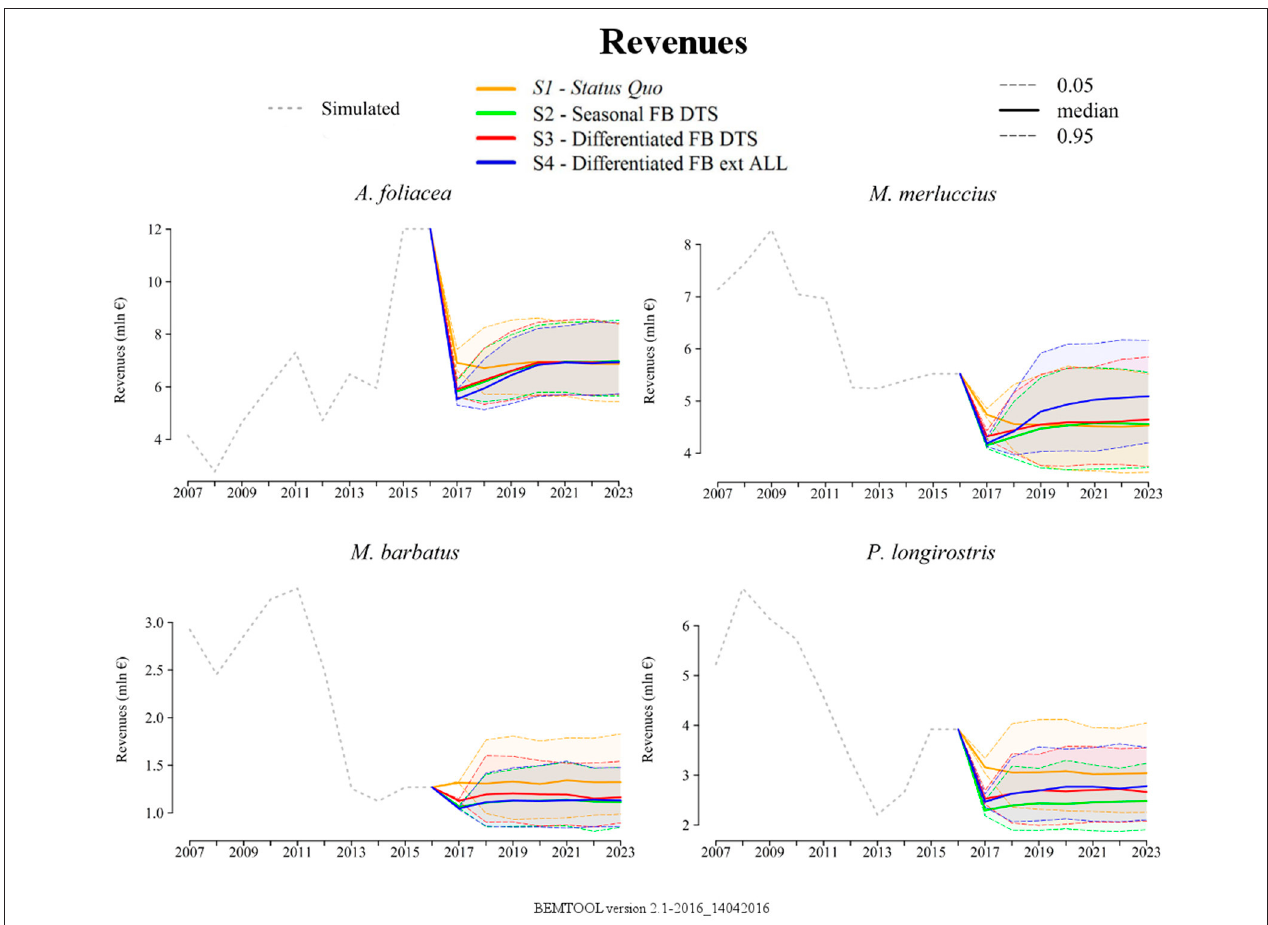
FIGURE 8 | Comparison among the scenarios of revenues (all gear) in the hindcasting (2007–2016) and forecasting (2017–2023) timelines. Dotted line, Hindcasting from the bioeconomic modeling tool (BEMTOOL).